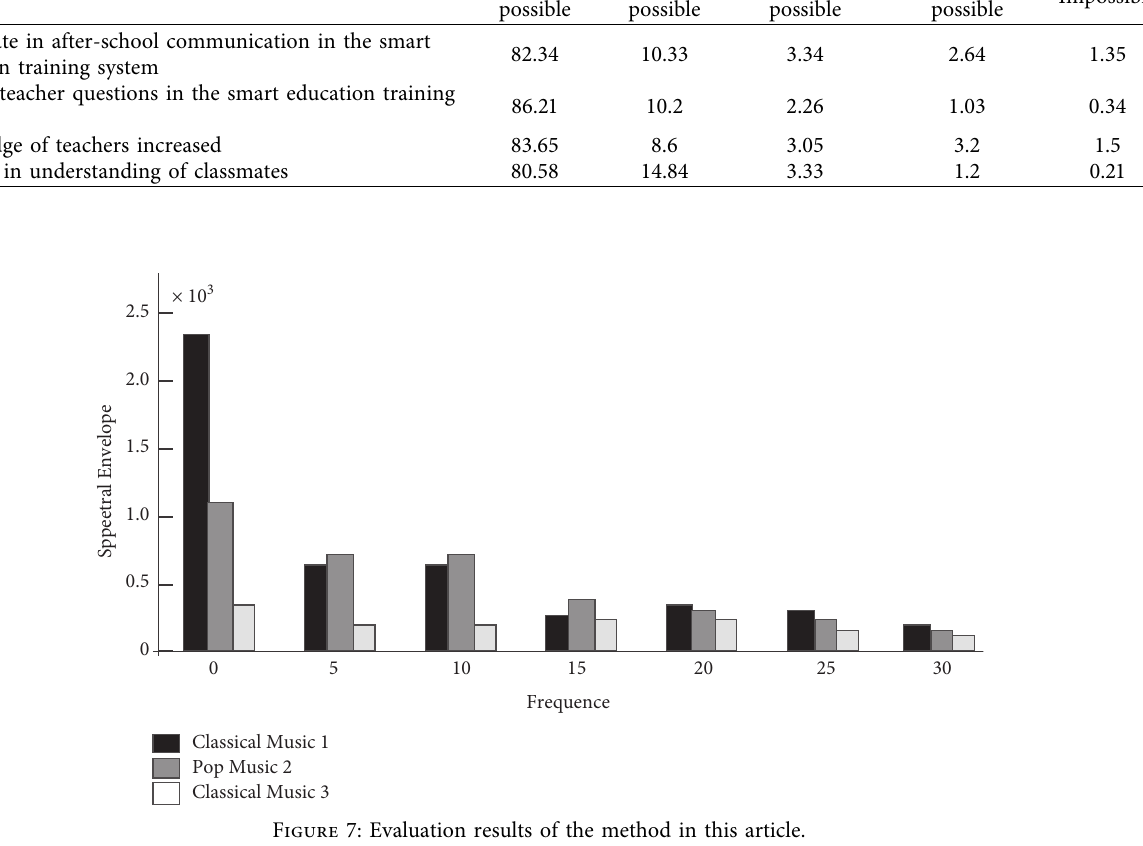
Table 3: The impact of the training system on students’ extracurricular communication. Type